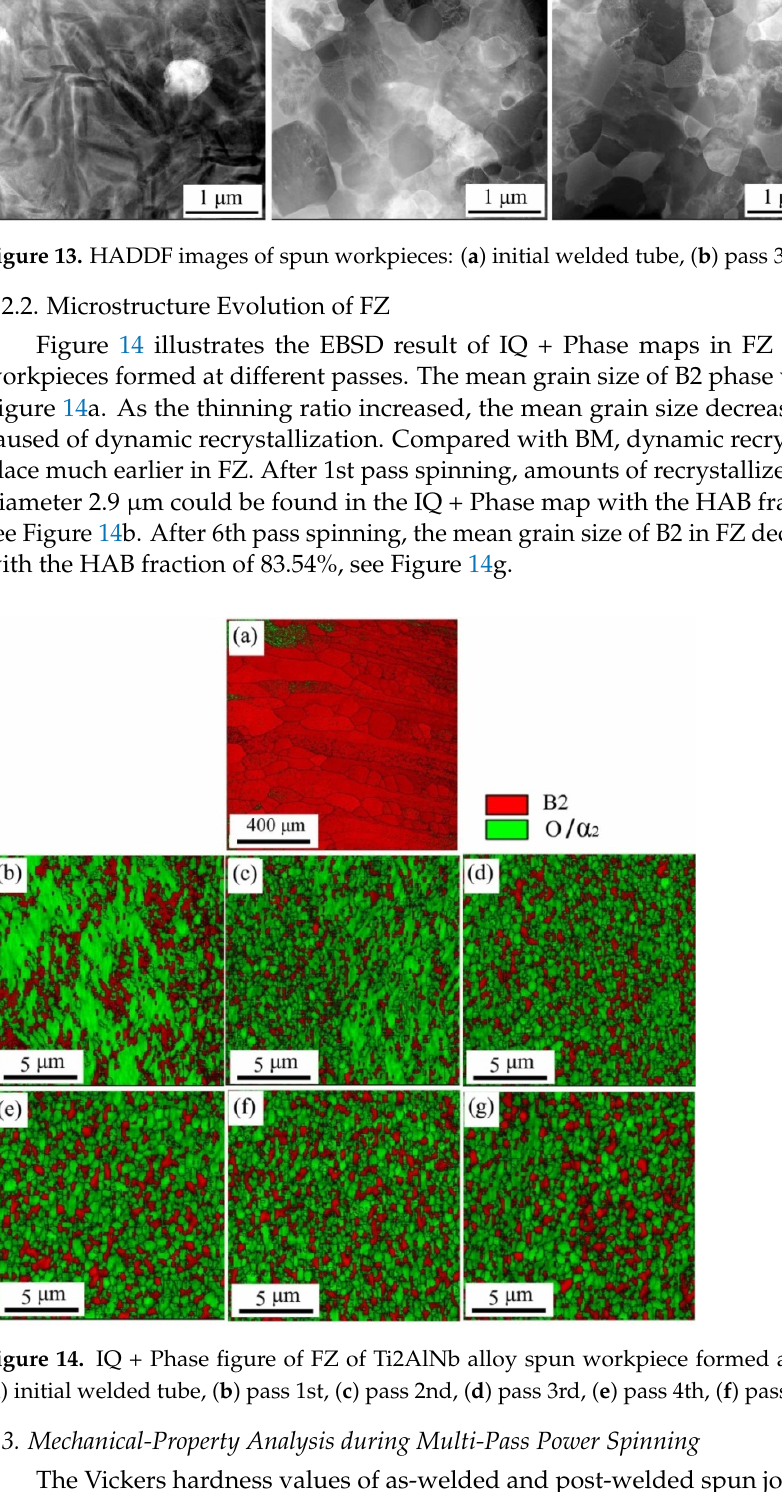
Figure 12. TEM result of the 6th pass spun tube ( ψ t = 74%): ( a ) bright field image, ( b ) selected area electron diffraction of ( a ), ( c – e ) local enlarged image with three features of ( a ). * The position marked by * corresponds to the diffraction pattern of Figure 12b.